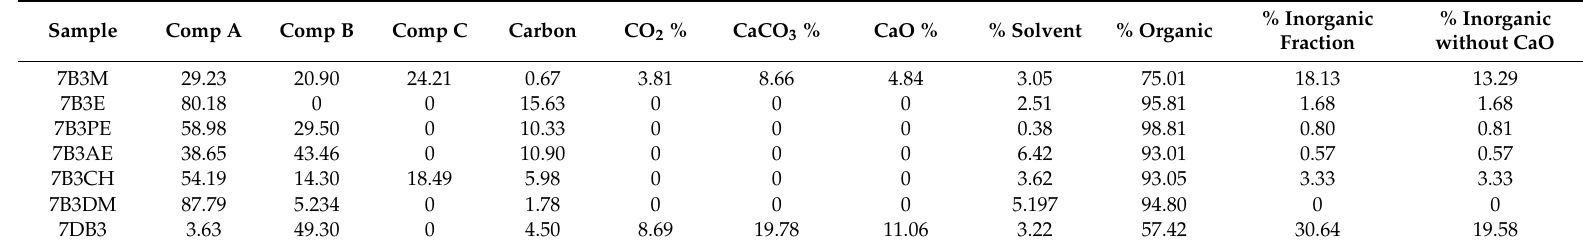
Table 3. TG data from the B3 sample and their